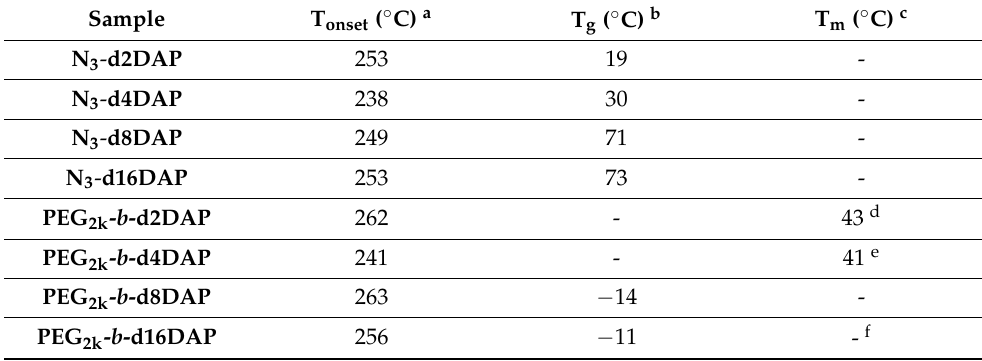
Table 2. Thermal properties of dendrons and linear–dendritic block copolymers (LDBCs). Sample